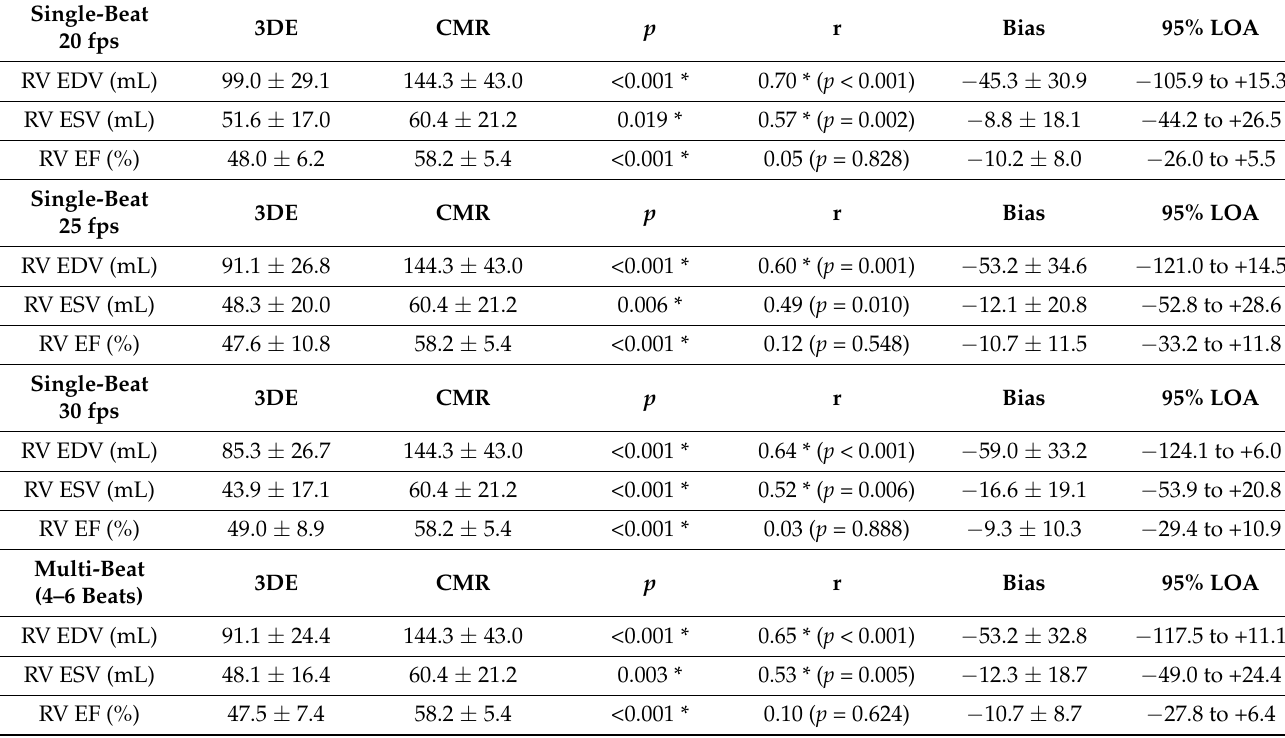
Table 5. Results of the validation study. Results of 3DE and CMR analysis of RV parameters are shown, and compared using paired Student t -test, Pearson’s correlation coefficient, and Bland–Altman analysis (Bias ± SD and 95% upper LOA—95% lower